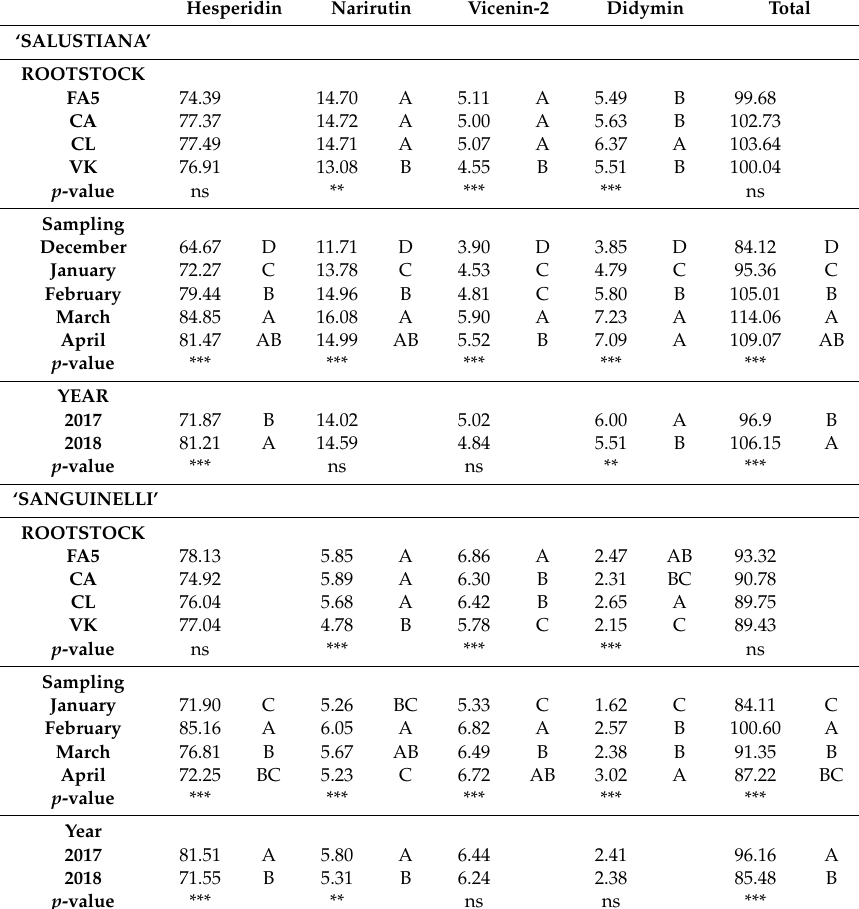
Table 2. E ff ect of rootstock, sampling date, and year on phenolic compound concentration in